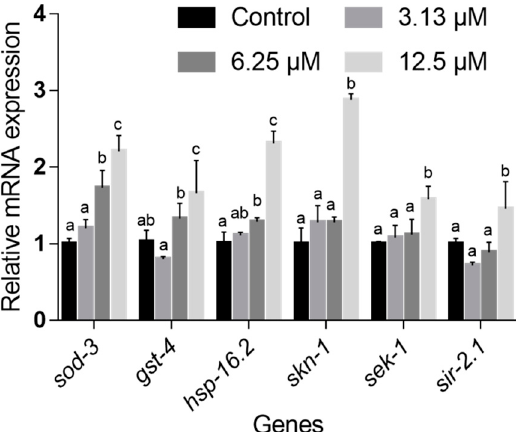
Figure 9. Effect of NOB on antioxidant gene expression in C. elegans. Data are shown as mean ± SD, n = 3. Bars with different letters in each group indicated statistical significance ( p < 0.05).